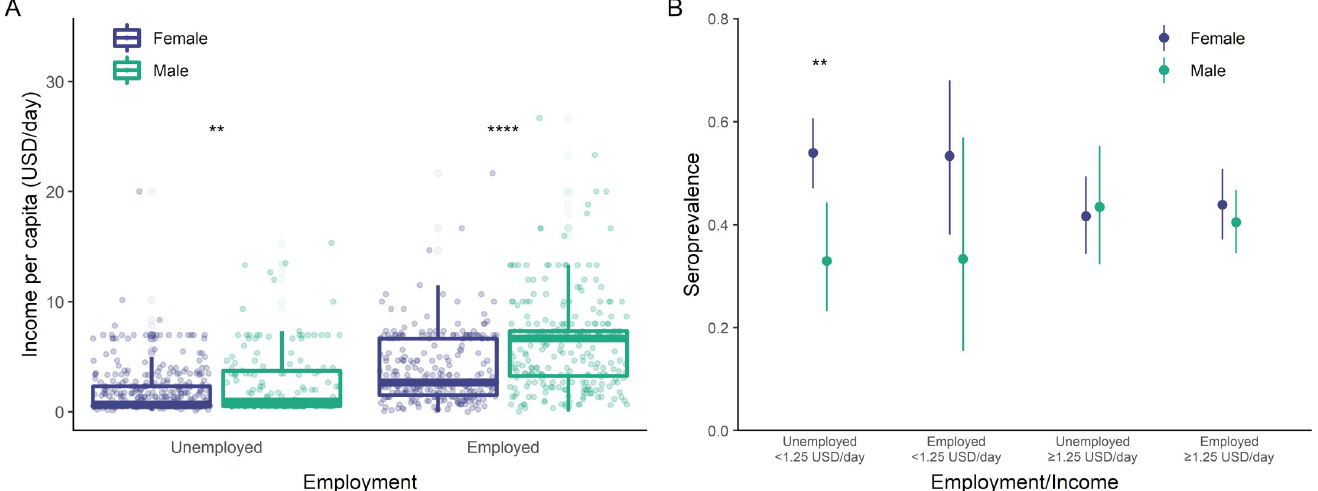
Fig 3. Socioeconomic vulnerability among women. (A) Household income (per capita) by employment status and gender. (B) Seroprevalence by household income (per capita), employment status, and gender. Asterisks indicate statistically significant differences (2-tailed t test, Bonferroni-adjusted p < 0.05: � ; < 0.01: �� ; < 0.001: ��� ; α = 0.0125 in panels (A and B)). USD, US